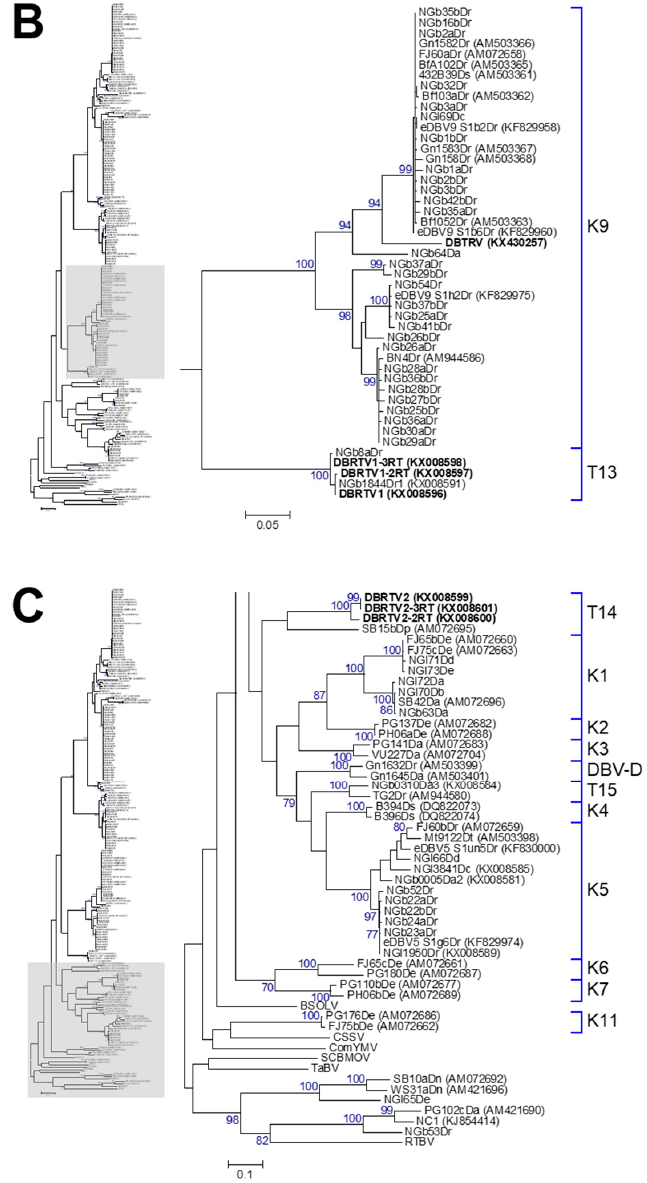
Figure 4. Bootstrap consensus phylogenetic tree using the maximum likelihood method built from the badnavirus 527–528-bp-long partial RT-RNaseH nucleotide sequences of 114 yam badnavirus sequences determined in this study. Included in the analysis are partial RT-RNaseH sequences with names and accession numbers from GenBank of previously analysed yam samples by Bömer et al. [33], Bousalem et al. [34], Eni et al. [35], Kenyon et al. [3], Seal et al. [38] and Umber et al. [39,72]. Equivalent sequences from Cacao swollen shoot virus (CSSV, AJ781003), Banana streak OL virus (BSOLV, AJ002234), Commelina yellow mottle virus (ComYMV, NC001343), Sugarcane bacilliform MO virus (SCBMOV, M89923), Taro bacilliform virus (TaBV, AF357836) and outgroup Rice tungro bacilliform virus (RTBV, X57924) were added, as well as representative sequences of all monophyletic groups described by Bousalem et al. [34] (where DBV-D: Dioscorea bacilliform virus D), by Umber et al. [39] and by Kenyon et al. [3], denoted by U12 and K1–K11 respectively. Three novel monophyletic groups, T13–15, described by Bömer et al. [33] were also included. Sequences depicted in bold represent partial RT-RNaseH sequences of characterised episomal full-length DBV genomes currently available in GenBank. The phylogenetic tree was divided into sub-groups with groups K8 and U12 presented in ( A ); K9 and T13 shown in ( B ) and DBV-D, K1–11, T14, T15 as well as the outgroups shown in ( C ). The bootstrap analysis of the sequences was 1000 replicates and the cut-off value was 70%. The scale bars show the number of substitutions per